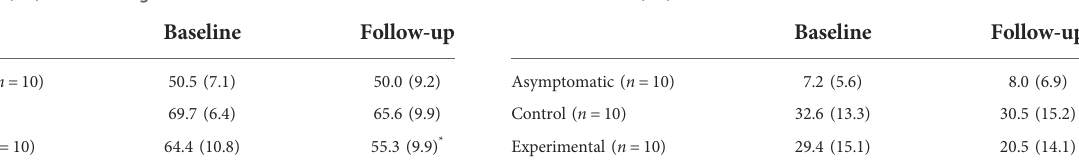
TABLE 3 Mean (SD) PROMIS anger scores. TABLE 4 Mean (SD) PCL-M scores.